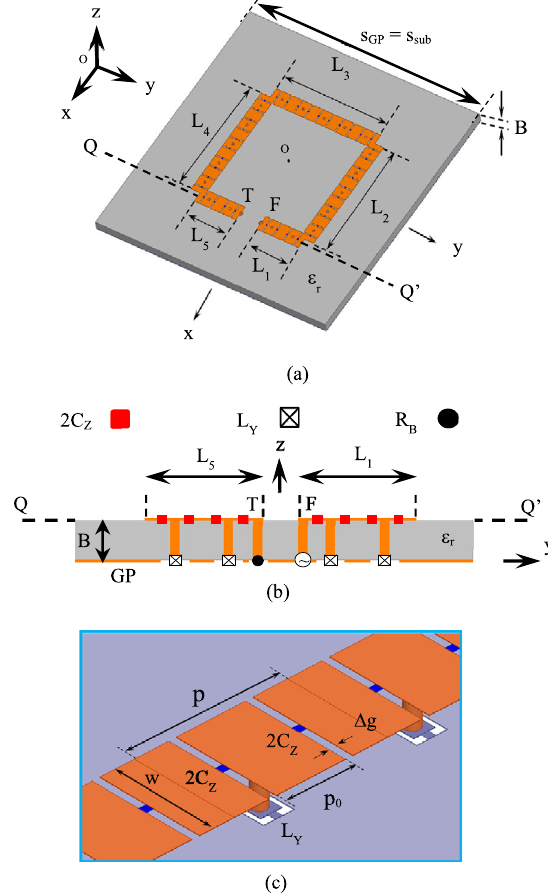
Fig. 2. Metaloop antenna. (a) Perspective view. (b) Side view. (c) Arm unit